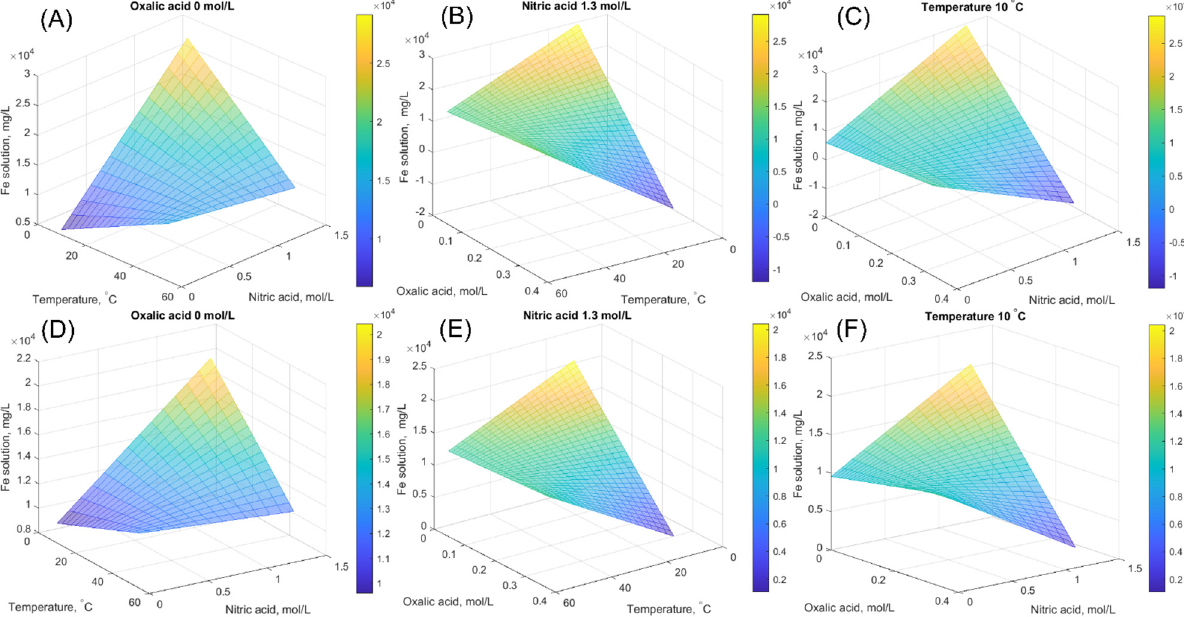
Figure 5. Surface plots of equilibrium iron concentration calculated by the developed model at fixed oxalic acid concentration, at fixed nitric acid concentration, and at fixed temperature. ( A – C ) are for magnetite and ( D – F ) are for